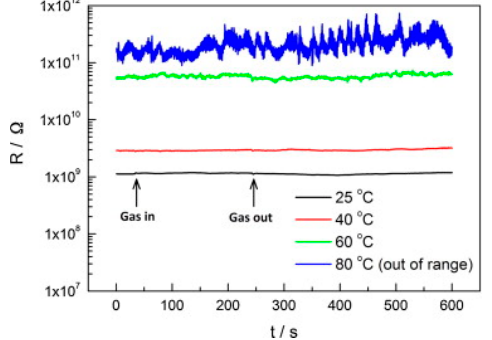
Figure 15. 100 ppm formaldehyde sensing results using TiO 2 with humidity at 13.68 mg/L vs. working temperatures without UV irradiation. Reproduced with permission from [51].